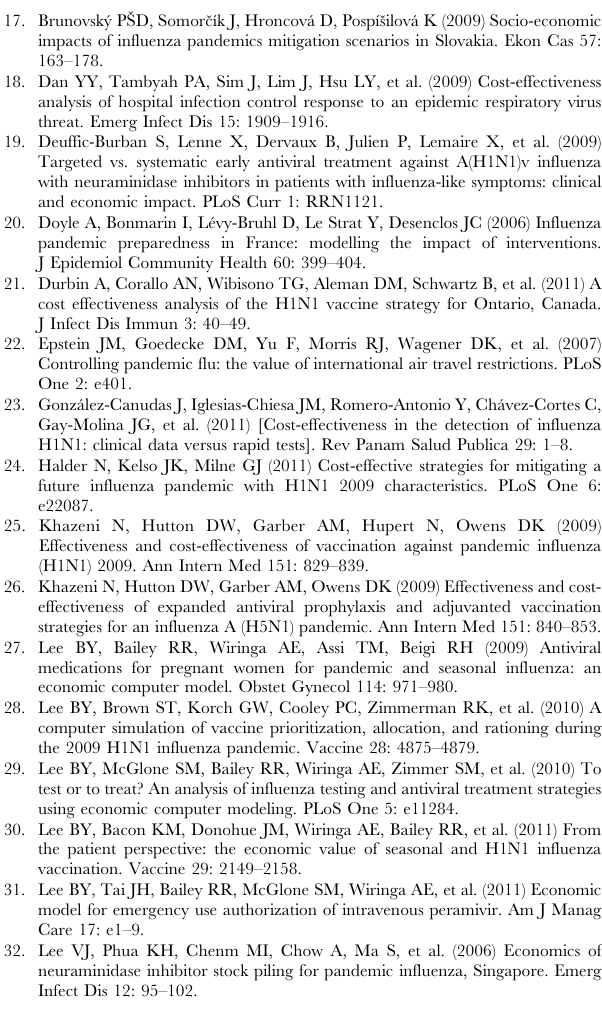
Table S1 Searches performed on electronic sources of information. Table S2 Search strategy employed for MEDLINE (via PubMed). Table S3 Hierarchies of data sources according to quality of evidence [ 6 ] (adapted [ 7 ] ). Table S4 Characteristics of reviewed studies. Table S5 Antiviral drug and vaccine regimens.